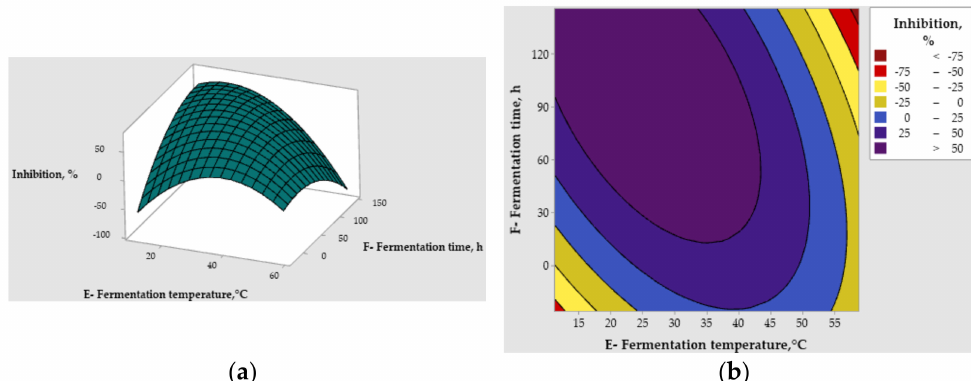
Figure 2. Surface ( a ) and contour ( b ) plots for the two-way interactions between the significant fermentation variables E and F on the antifungal activity (inhibition ratio, %) against Aspergillus flavus . The mean of the factors A to F is given in Table